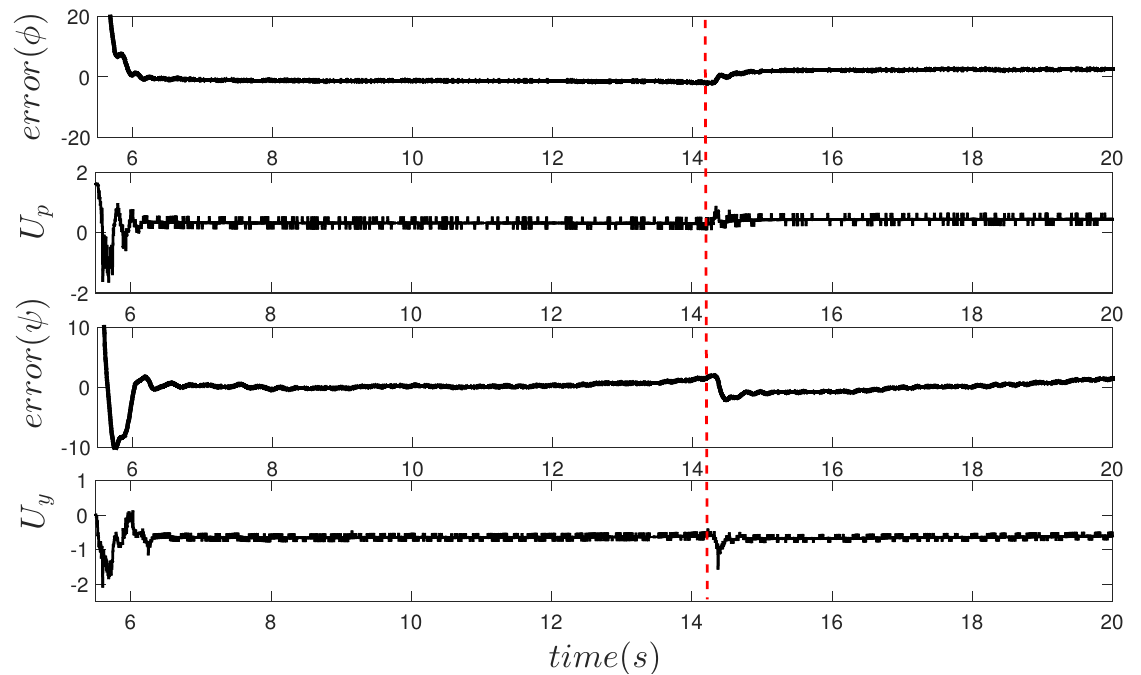
Figure 11. Response to the presence of failure in actuator f a 1 of